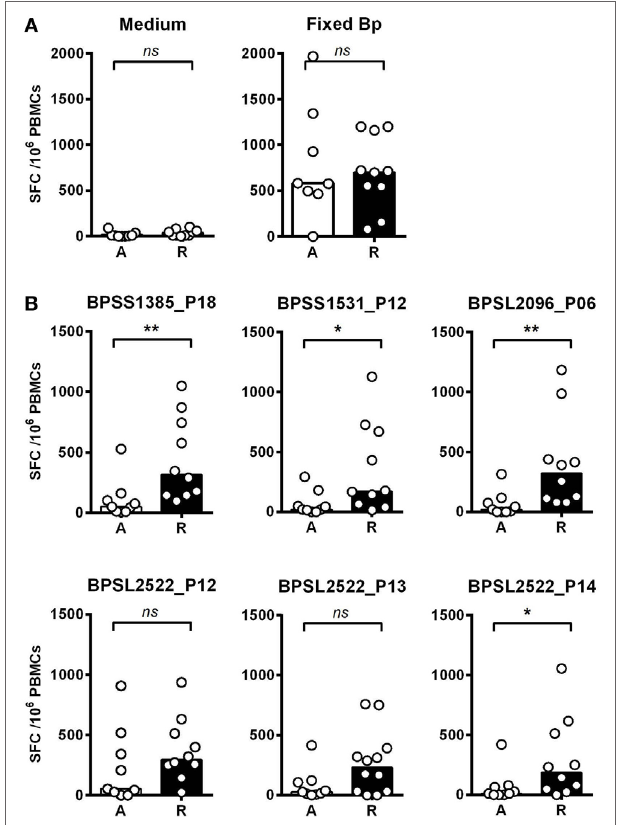
FigUre 3 | IFN γ responses to Burkholderia pseudomallei (Bp) and T-cell immunoprevalent peptides in patients with acute septicemic melioidosis compared with recovered individuals. IFN γ response to the top six immunoprevalent peptides of Bp measured by ELISpot analysis of peripheral mononuclear cell (PBMC) taken from patients with a diagnosis of acute melioidosis (A, n = 9) and melioidosis recovered individuals (R, n = 10). (a) shows the results for medium only control and paraformaldehyde (PFA) fixed Bp. (B) shows the results for six immunoprevalent peptides. Statistical significance was determined using Mann–Whitney U test; ns, not significant, * p < 0.05 and ** p <